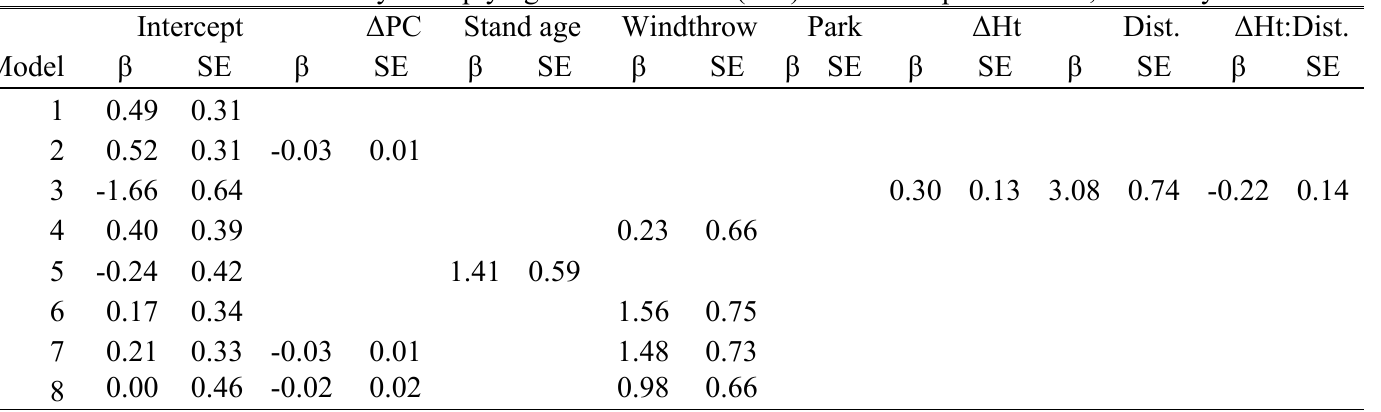
† Note that negative parameter values imply a positive relationship due to negative covariate values representing decrease in stand area Table A2.7 Parameter estimates for models examining variation in stand-level trends (between circa 1994 and 2014) in abundance Magnolia Warbler in aspen dominated mixedwood forests in central Saskatchewan. 85% Confidence Intervals can be obtained as β ± 1.44* SE. NOTE: Parameter values were rescaled by multiplying with a constant (100) for ease of presentation, divide by 100 to obtain